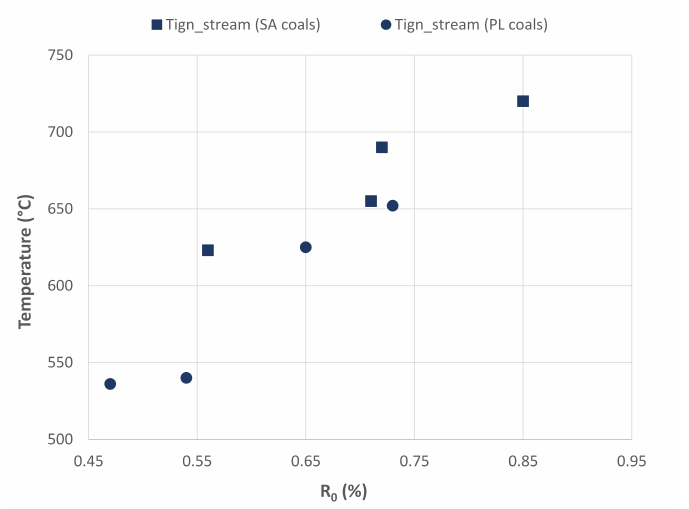
Figure 6. Effect of vitrinite reflectance ( R 0 ) on the dispersed coal–particle stream ignition temperature, T stream . ign